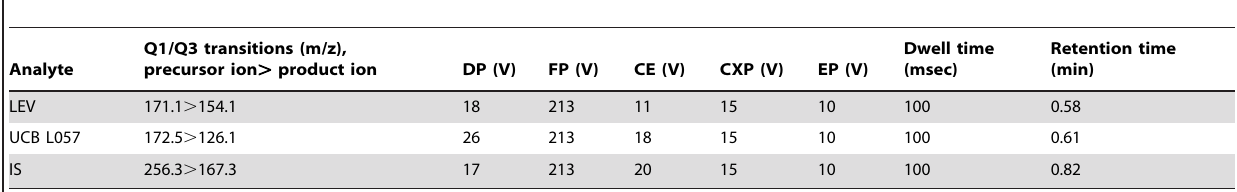
Table 1. Optimized mass spectrometer voltage settings including MS/MS transitions for all analytes evaluated.